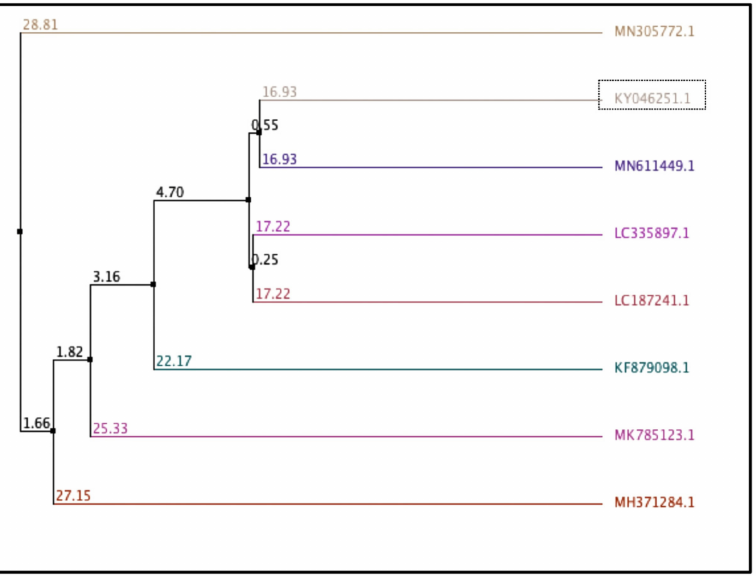
Figure 1. Average distance calculated based on percentage of similarity between sequences. Bacillus strains from the database and the contig 16S rRNA sequence of Fa17.2. Trees were calculated based on a measure of similarity between each pair of sequences in the alignment: PID. The percentage identity between the two sequences at each aligned position. The number on the branch is the bootstrap value that indicates the extent of relatedness between two subjects. Legend: KY046251.1: B. subtilis strain Fa17.2; MH371284.1: B. subtilis strain C1; MK785123.1: B. vallismortis strain VS-5; LC335897.1: B. subtilis PH; KF879098.1: Bacillus spp. BAB-2797; MN305772.1: B. subtilis strain OTG009; MN611449.1: B. subtilis strain subtilis ; LC187241.1: Lactobacillus murinus strain